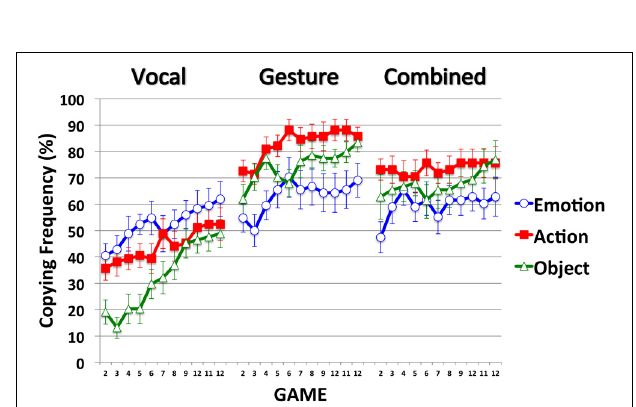
FIGURE 5 | Mean copying frequency, expressed as percentage scores, of signs across Items (Emotion, Action, Object) and Games (2–12) for participants in the Vocal, Gesture and Combined modalities. Error bars indicate the standard errors of the